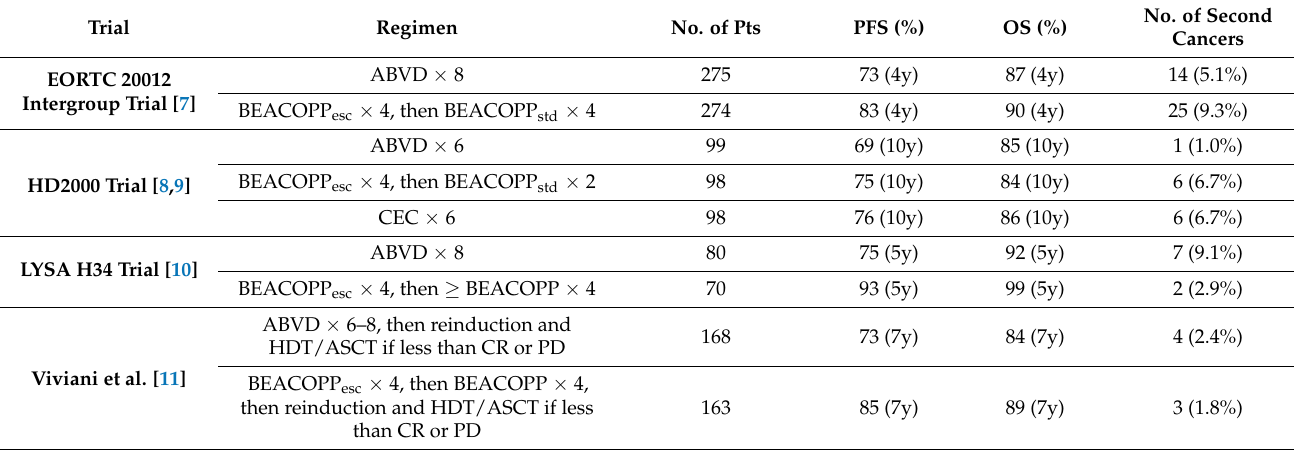
Table 2. Summary of studies comparing ABVD and BEACOPP